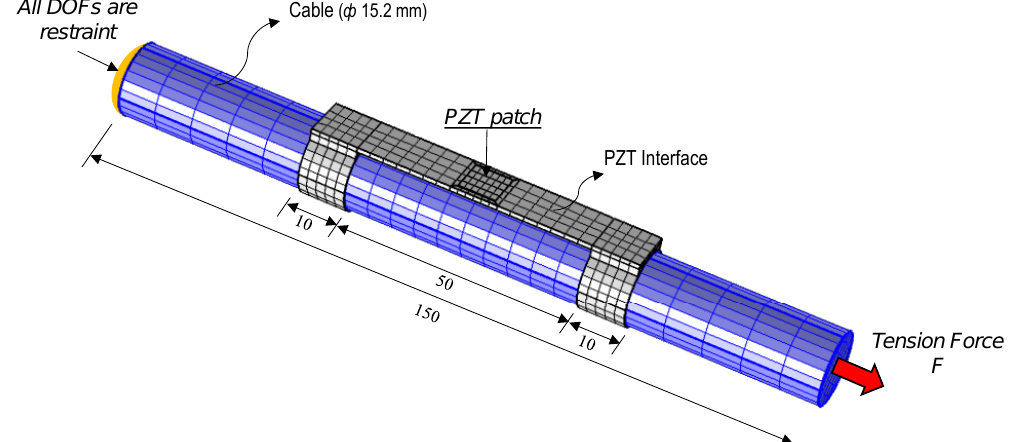
Figure 7. Finite element modeling of the axial cylindrical member with PZT interface (unit: mm).